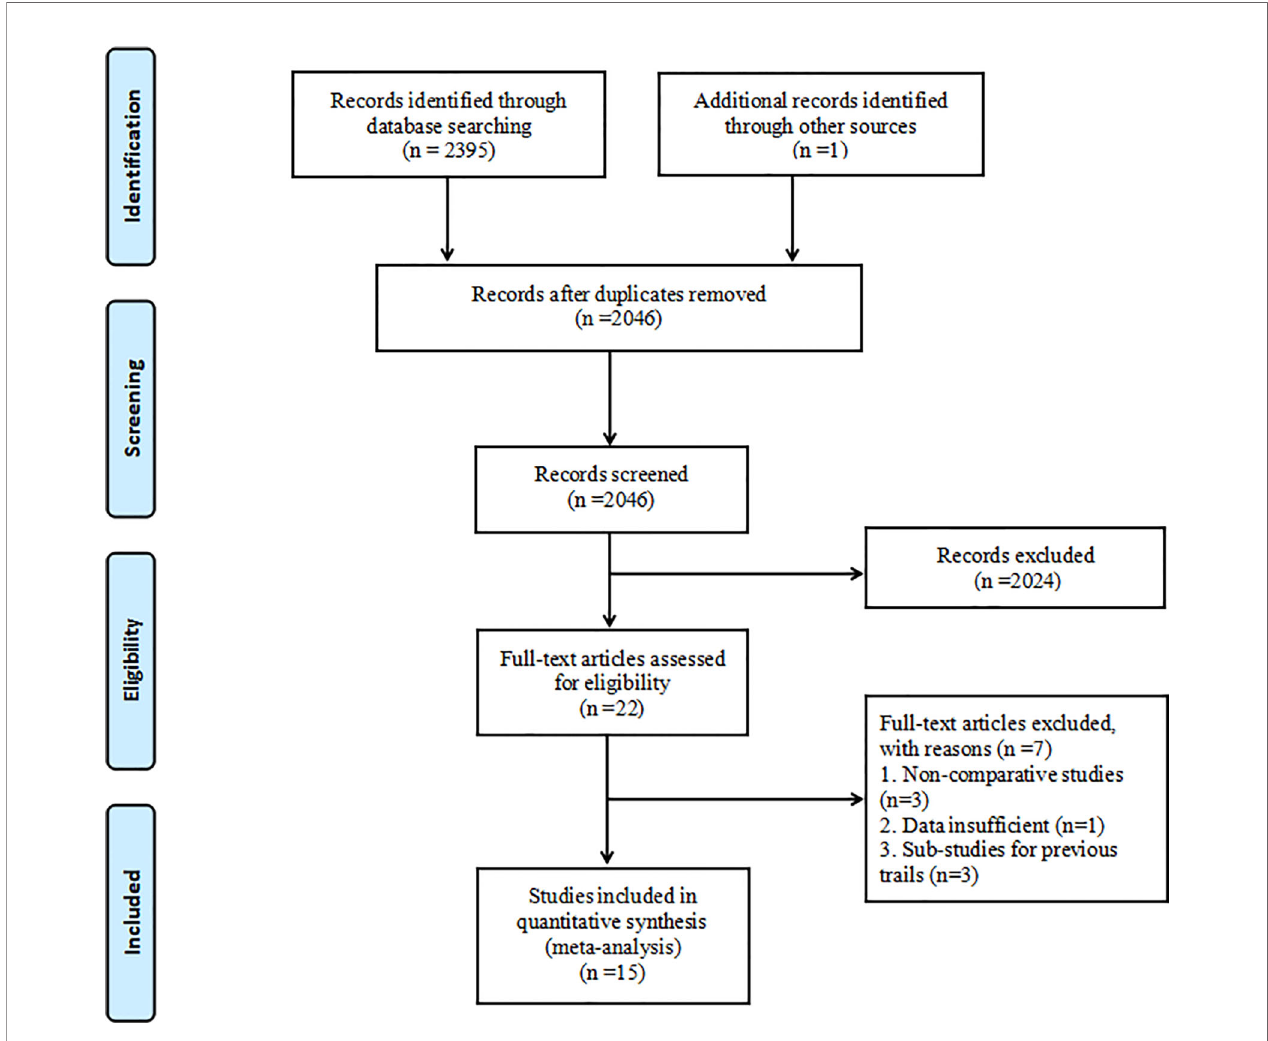
FIGURE 1 | Flowchart of the study selection